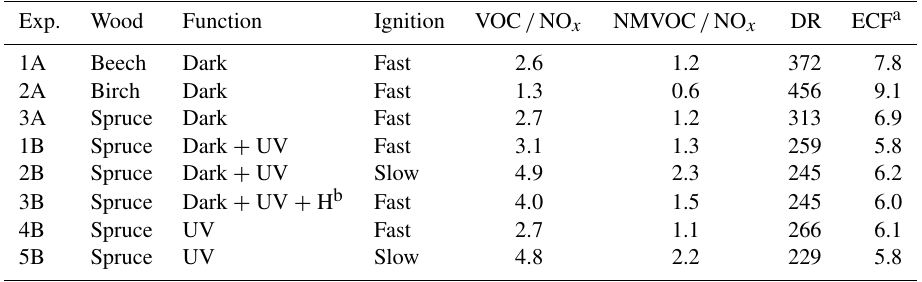
Table 1. Overview of the experimental parameters in the smog chamber experiments: VOC-to-NO x ratio (VOC / NO x ; ppbvppbv − 1 ), non-methane VOC-to-NO x ratio (NMVOC / NO x ; ppbvppbv − 1 ), dilution ratio (DR) and the specific emission conversion factors (ECFs;m 3 kg − 1 fuel) determined for each logwood combustion experiment. Exp. Wood Function Ignition VOC / NO x NMVOC / NO x DR ECF a 1A Beech Dark